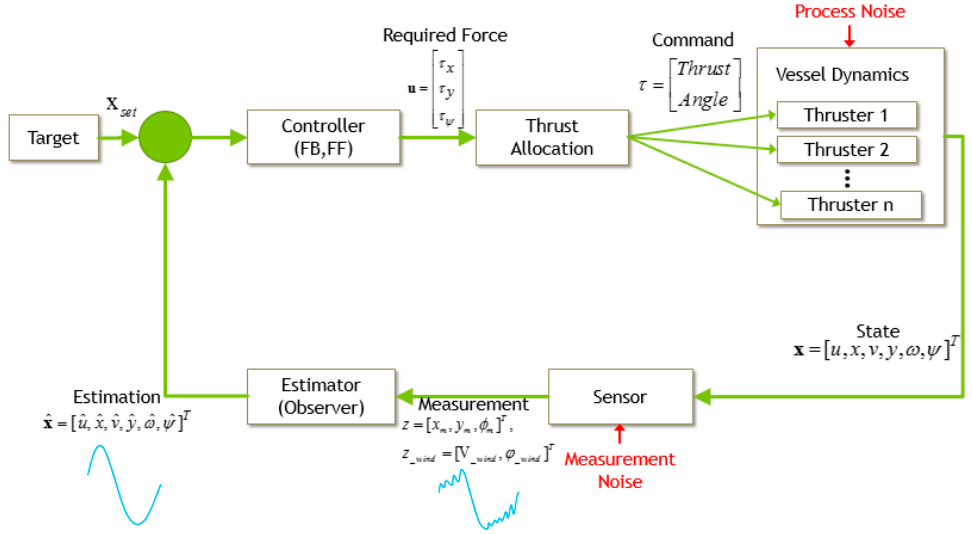
Figure 1 . Conventional DP-Control Frame. Figure 1. Conventional DP-Control